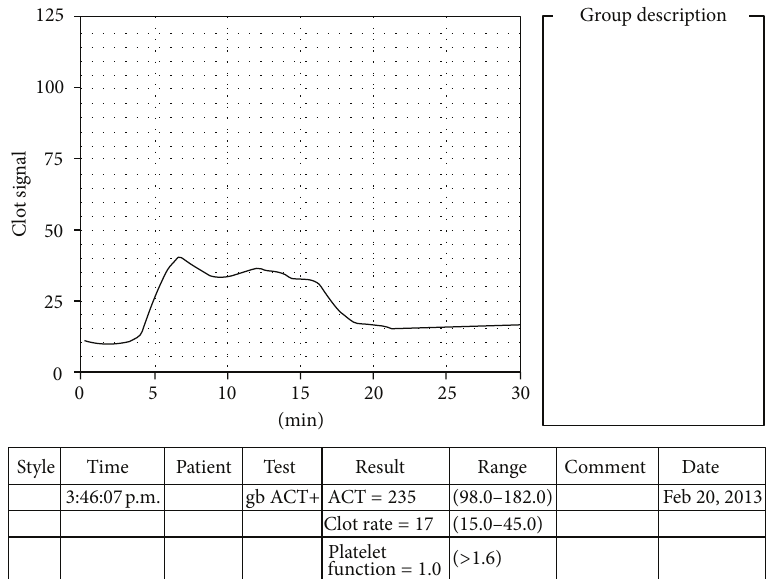
Figure 3: Hyperfibrinolysis as detected on sonoclot signature. The characteristic rise of the signature as depicted by R2 peak (suggestive of fibrin gel tightening by platelets) is not seen. Platelet function is subnormal (as calculated from the R3 gradient by the analyser). The hyperfibrinolysis in this case was confirmed by inspecting the sample in the cuvette immediately after the test procedure and was found to be in liquid state. Table 4: Correlation obtained between sonoclot parameters and conventional coagulation variables in patients with liver disease. Conventional